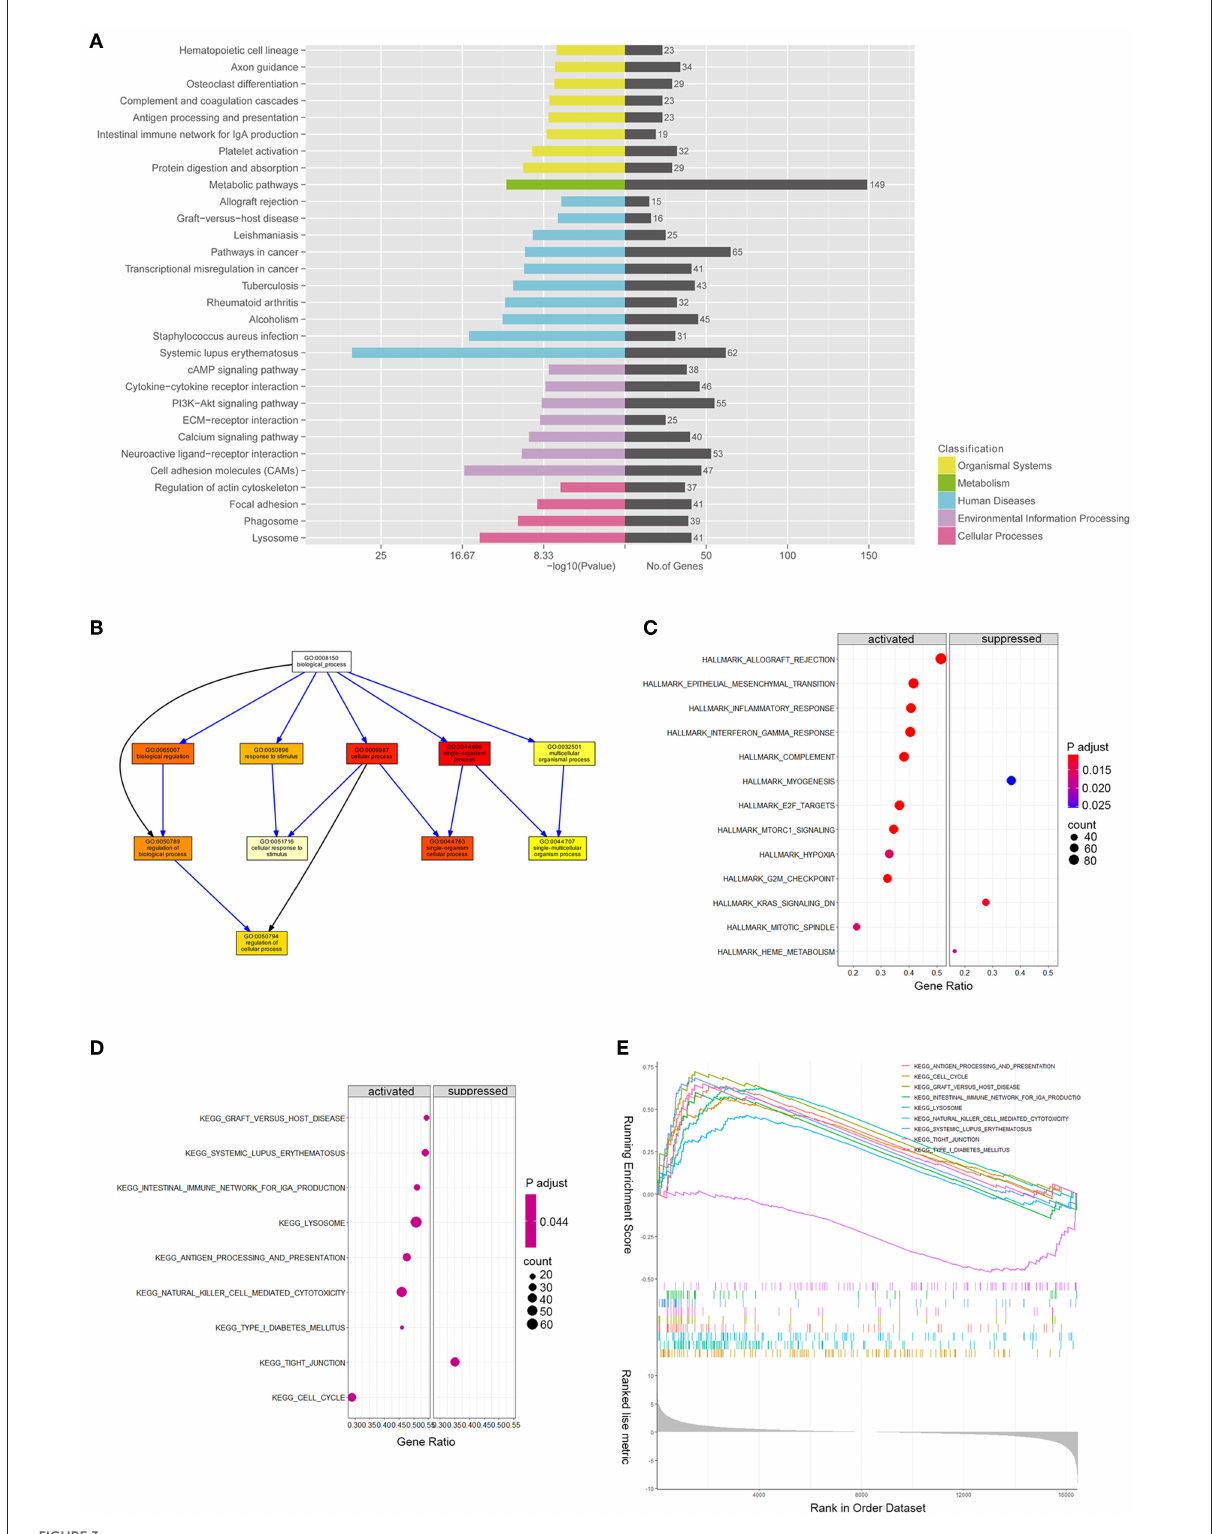
FIGURE3 mRNA expression profiles between patients with ASOand healthy donors. (A) Kyoto Encyclopedia of Genes and Genomes pathway enrichment results of differentially expressed genes (DEGs) between patients with ASO and healthy donors; (B) Directed Acyclic Graph shows the gene ontology (GO) analysis results of DEGs; (C) A bubble diagram of gene set enrichment analysis (GSEA) of hallmark pathways; (D) A bubble diagram of GSEA of KEGG pathways; and (E) GSEA ranking plot of the KEGG enrichment